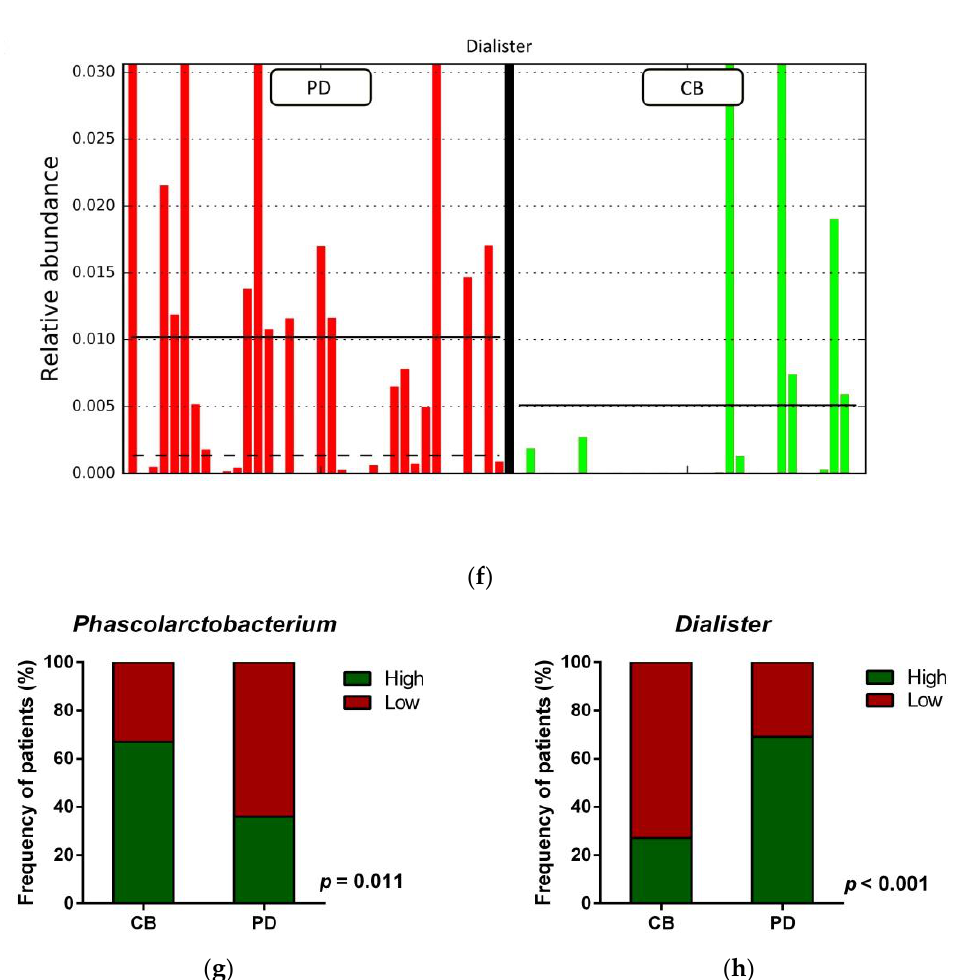
Figure 4. Compositional differences of the gut microbiota between CB and PD groups. ( a ) Venn diagram depicting shared and unique taxa for CB and PD groups; 618 taxa were identified as core microbiota (shared taxa). ( b ) Comparisons of the relative abundance at the genus level among CB (green) and PD (red) groups; ** p < 0.01. ( c ) Differential abundance analysis using linear discriminant analysis (LDA) effect size (LEfSe) in patients stratified according to response to ICB. ( d ) Taxonomic cladogram from the LEfSe analysis depicting differences in fecal taxa in CB and PD patients. Dot size is proportional to the abundance of the taxon. Green legends represent CB patients and red legends represent PD patients. ( e ) Differential abundance analysis using linear discriminant analysis (LDA) effect size (LEfSe) for the genera Phascolarctobacterium in PD and CB patients; the solid straight lines represent the plot subgroup relative abundance means; the dotted straight lines represent the plot subgroup relative abundance medians. ( f ) Differential abundance analysis using linear discriminant analysis (LDA) effect size (LEfSe) for the genus Dialister in PD and CB patients; the solid straight lines represent the plot subgroup relative abundance means; the dotted straight lines represent the plot subgroup relative abundance medians. ( g ) Frequency of patients with high versus low relative abundance of Phascolarctobacterium in their stool samples according to response to ICB (CB and PD groups). ( h ) Frequency of patients with high versus low relative abundance of Dialister in their fecal samples according to the response to ICB (CB and PD groups). The cutoff value is the median of relative abundance: 1.92% ( Phascolarctobacterium ), 0.01% ( Dialister ). CB: clinical benefit group; PD: progression disease group. LDA score > 3.0; p < 0.05.